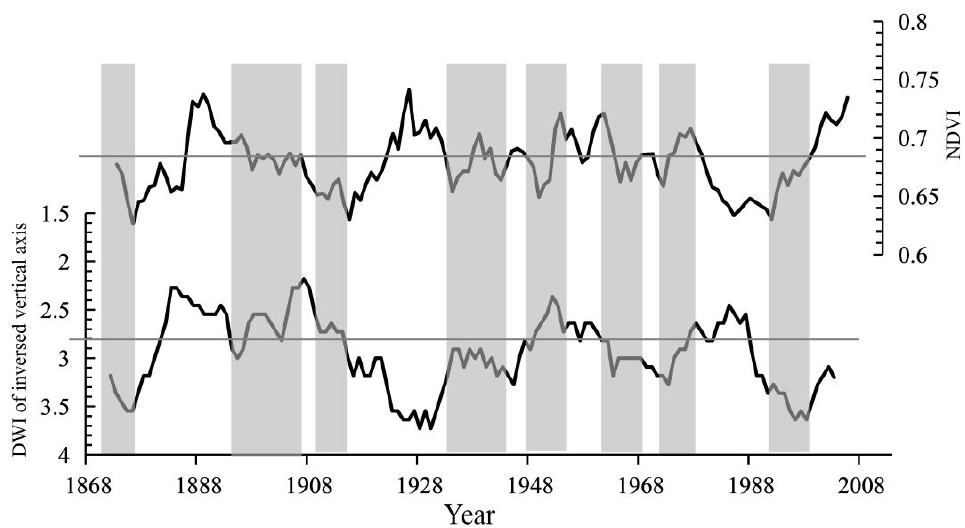
Figure 9. The 146a reconstructed annual maximum NDVI for Mt. Taibai and Baoji city dryness/wetness Index (DWI) of the inverse vertical axis. Vertical gray shading denotes the distinct periods of common trend.